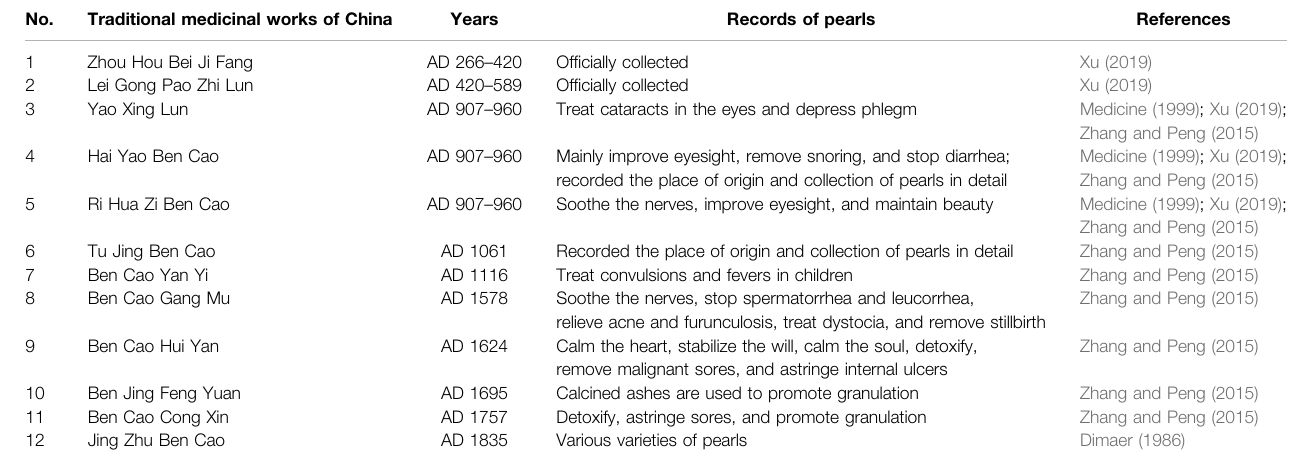
TABLE 1 | Records of pearls in traditional medicinal works of